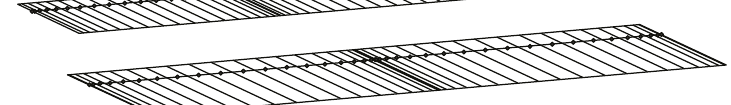
Figure 6: Grid generation with cosine clustering.